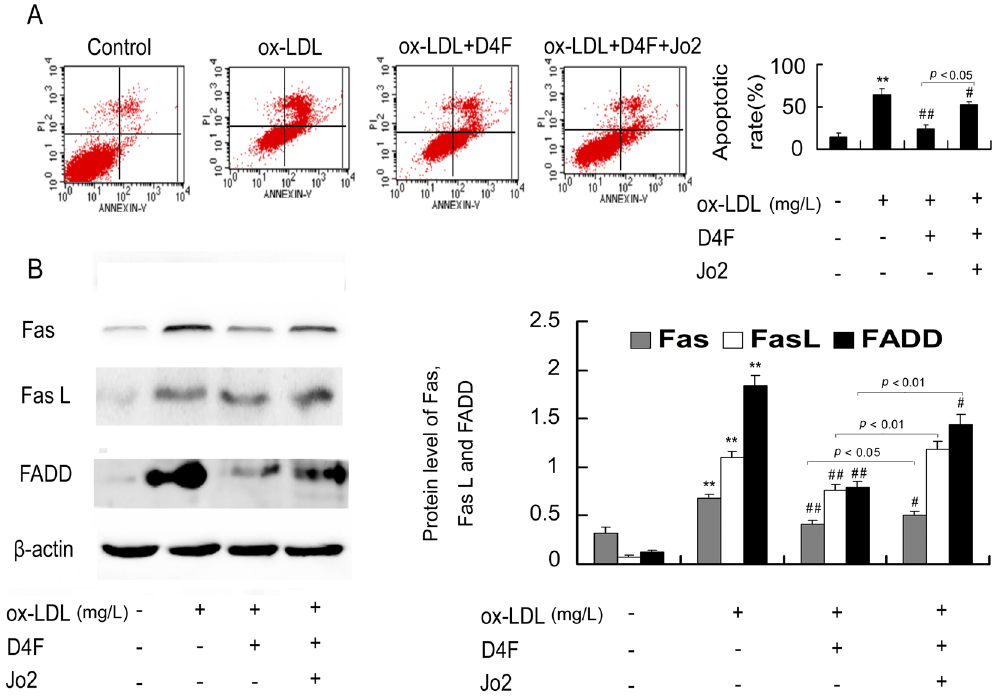
Figure 4. Jo2 reverses the protective effects of D4F on ox-LDL-treated RAW264.7 cells. Cells were pretreated with Jo2 (a Fas-activating antibody, 10 μ g/mL) or D4F (50 mg/L) for 1 h, and then 100 mg/L ox-LDL was added to the cells for 24 h. Cell apoptosis and the protein levels of Fas, FasL and FADD were detected using flow cytometry ( A ) and Western blot ( B ), respectively. Data are expressed as the mean ± SD of at least three independent experiments. * P < 0.05 and ** P < 0.01 versus vehicle-treated control; # P < 0.05 and ## P < 0.01 versus ox-LDL